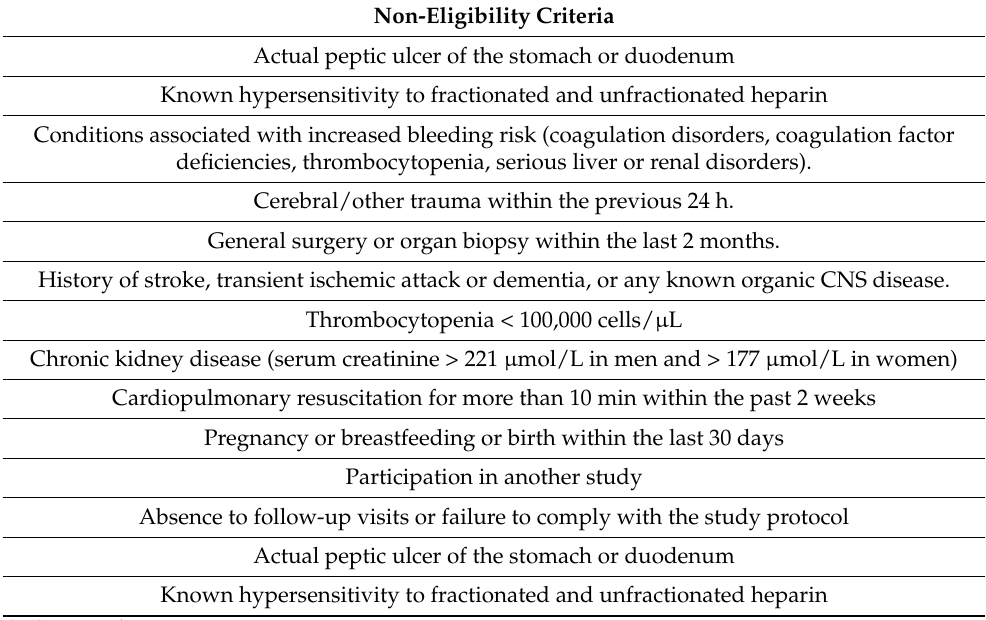
Table 1. Non-eligibility criteria.